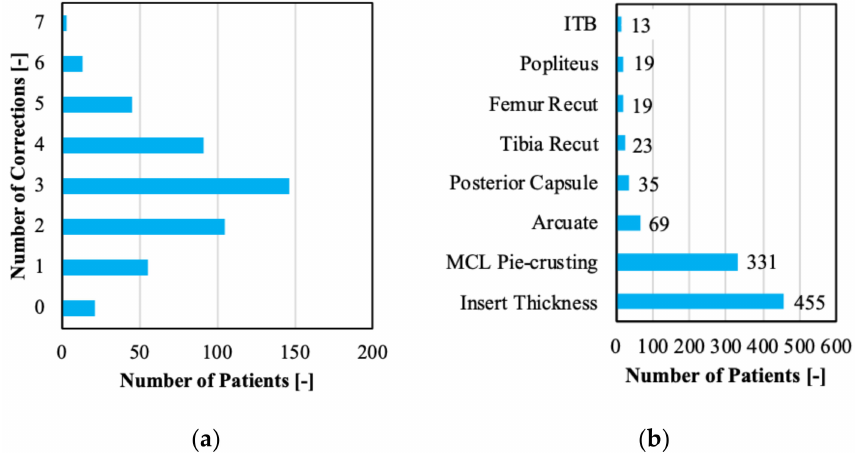
Figure 2. ( a ) Evaluation of number of surgical corrections per patient and ( b) type of surgical corrections encountered in the clinical